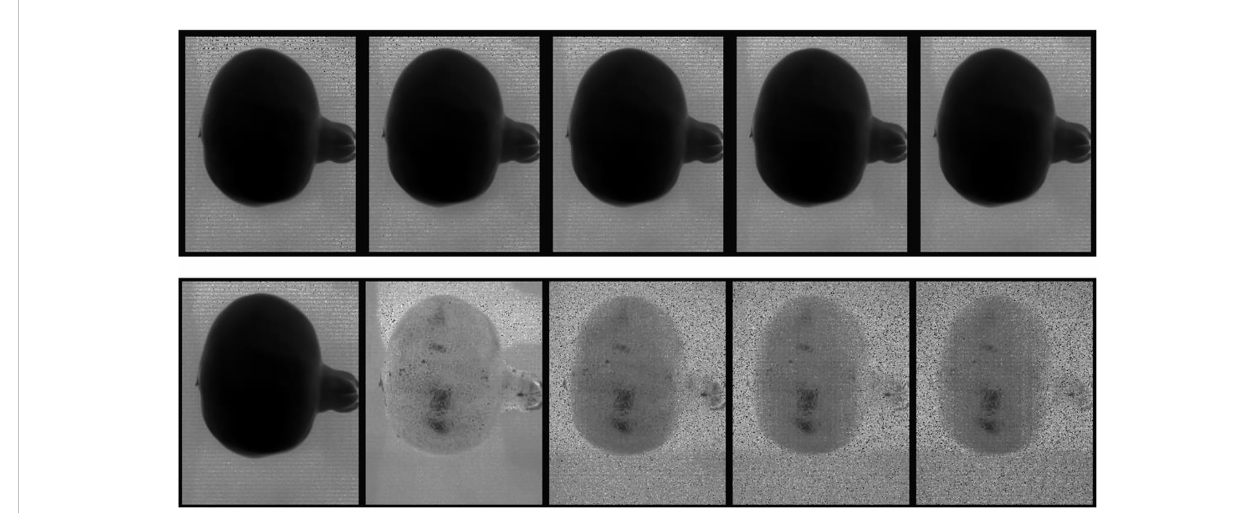
FIGURE 7 Display of the fi rst 5 spectral bands in the input data cube (top row) and the fi ve most informative bands (bottom row) of a typical fruit sample bruised from falling from 100